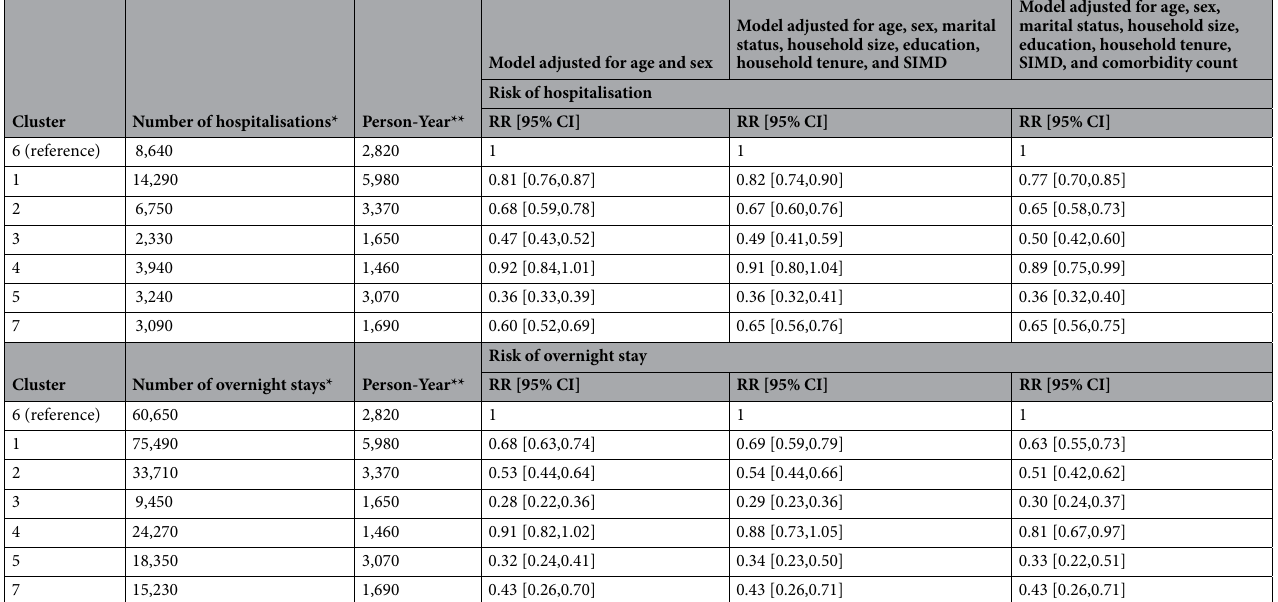
Model adjusted for age, sex, marital status, household size, education, household tenure, and SIMD Model adjusted for age and sex